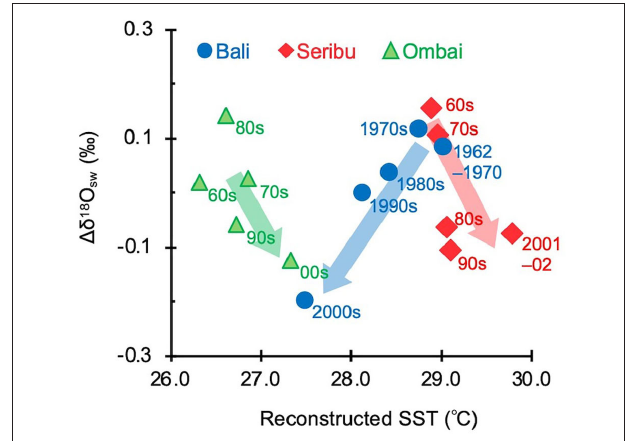
FIGURE 11 | Temporal relationship of 1 δ 18 O sw and SST at decadal timescales from 1960s to 2000s in Bali (blue circle) and Seribu (red diamond), and Ombai Strait (green triangle)